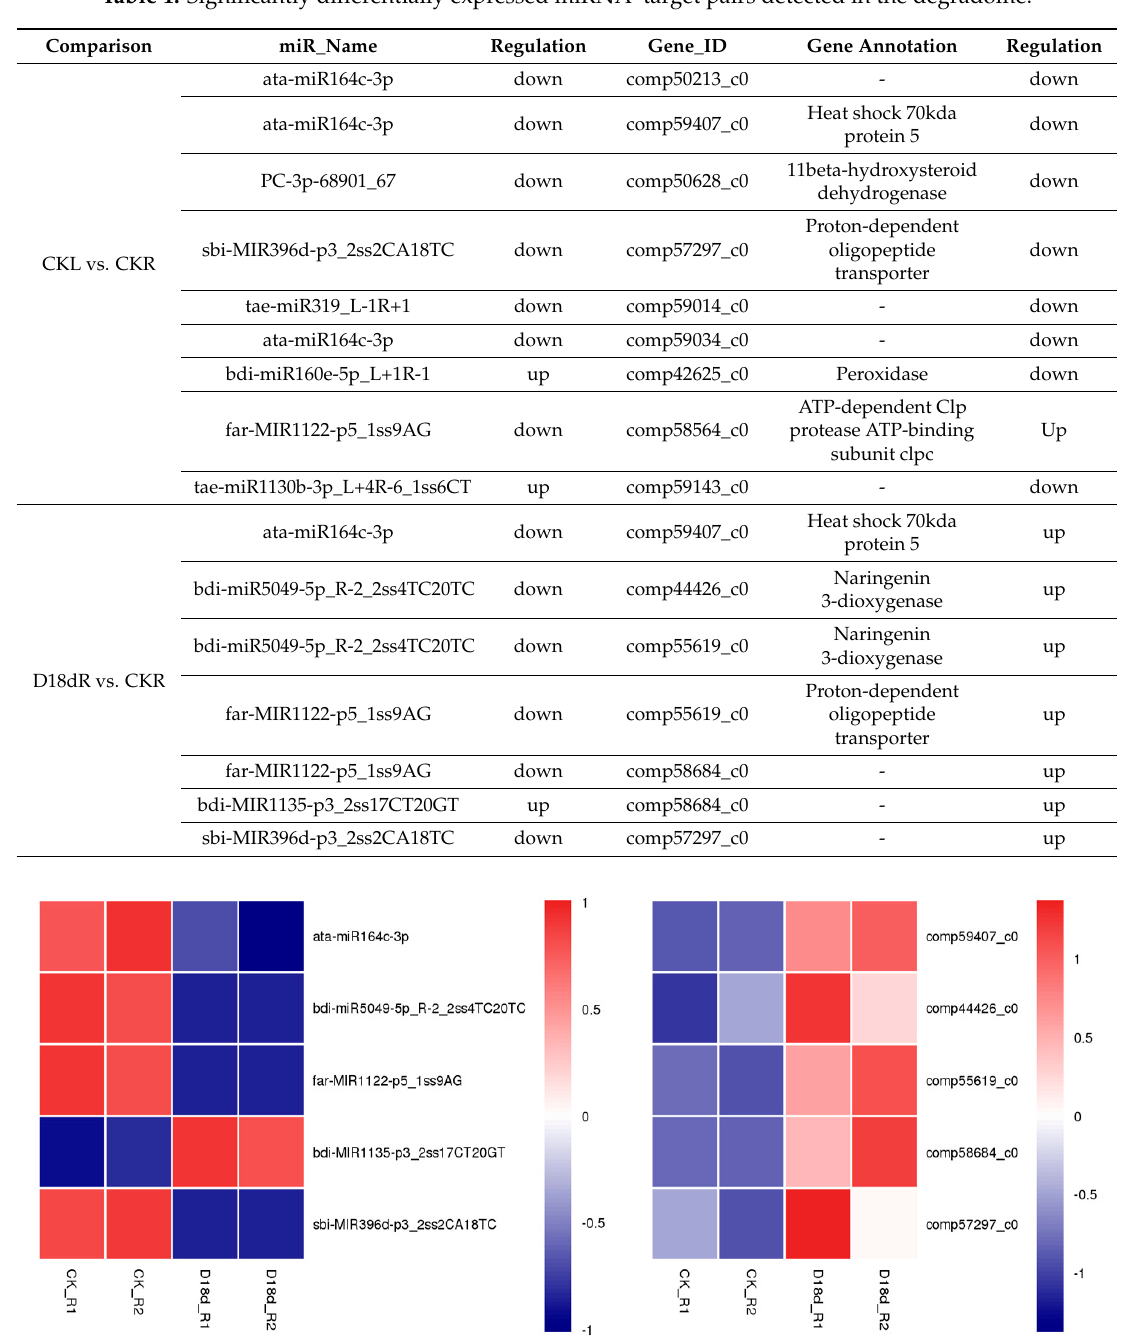
Figure 7. Expression of significantly expressed DEmiRs and their target DEG in the roots. The original expression values were normalized by Z-score normalization. Changes in color from blue to red denote changes in absolute signal intensity from − 2.0 to